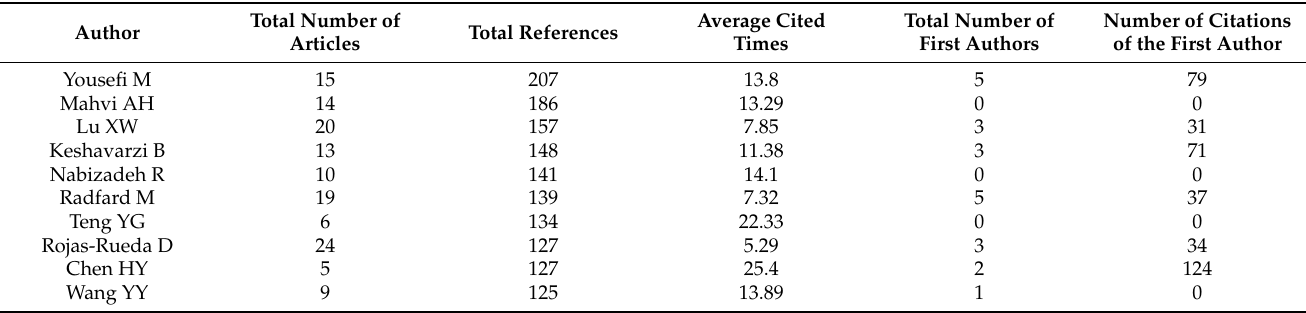
Table 4. Top 10 authors with